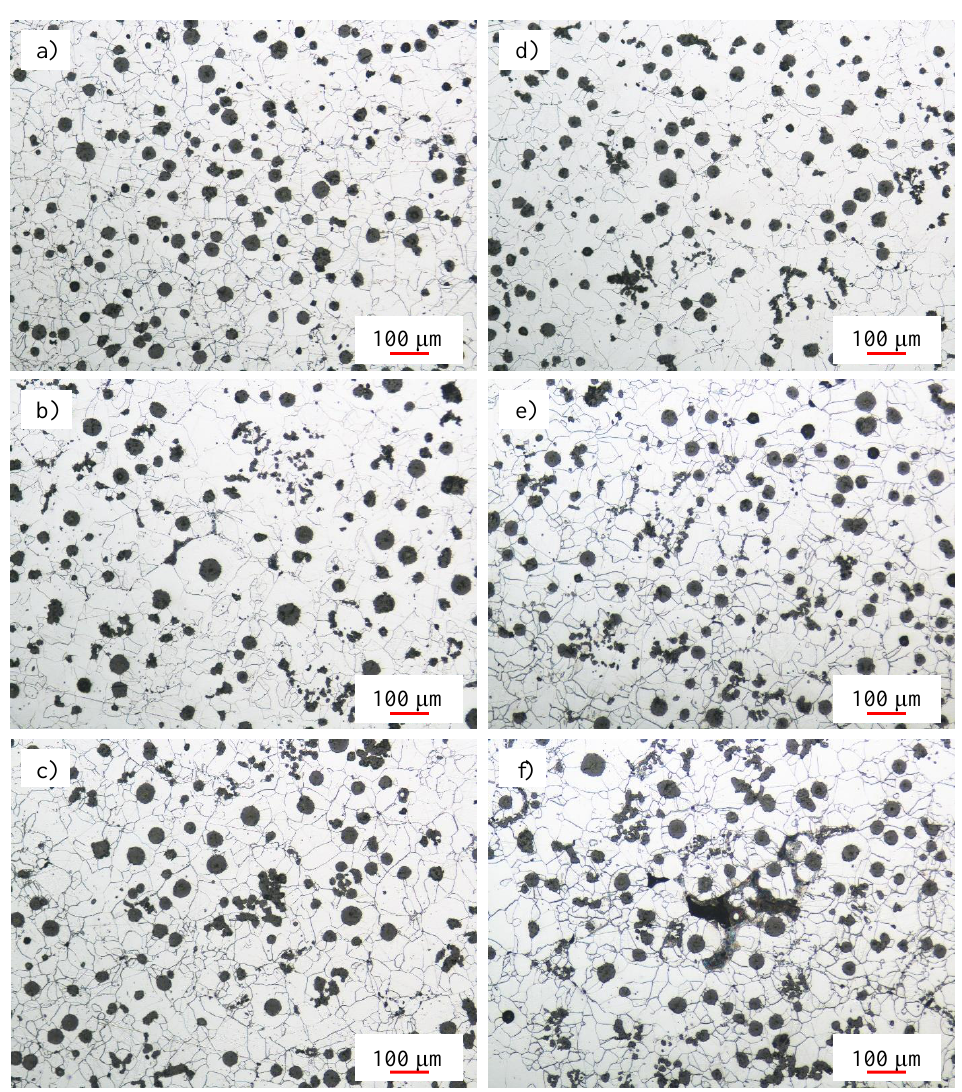
Figure 8. Micrograph of specimen taken from round bar shaped cast sample, etched with Nital 5%.